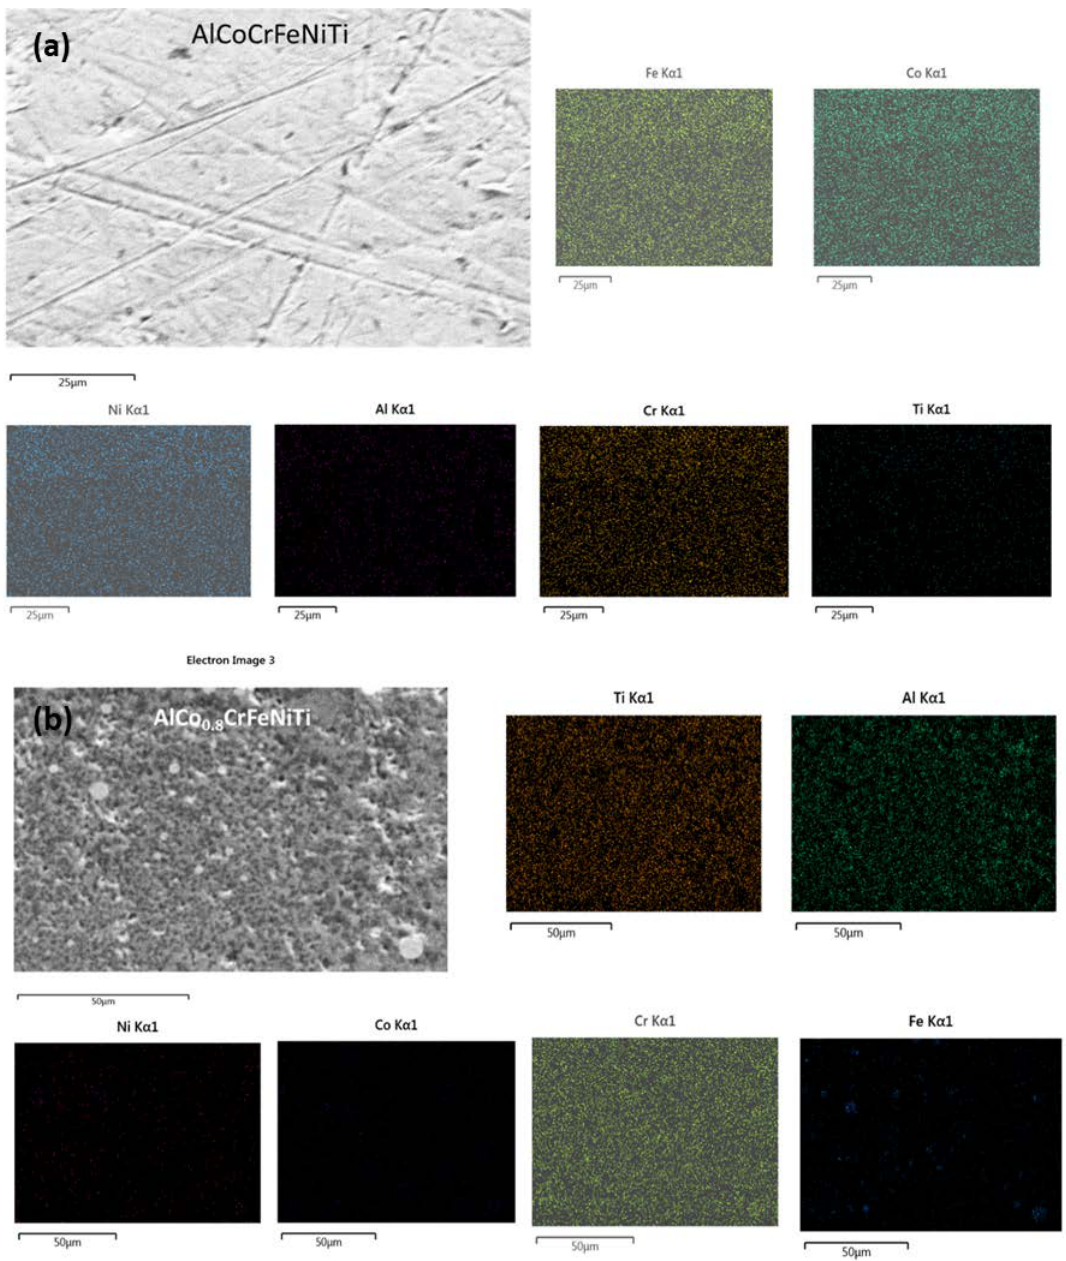
Figure A12. ( a ) SEM image and EDS elemental map of additive manufactured HEA sample (AlCoCrFeNiTi). ( b ) SEM image and EDS elemental map of additive manufactured HEA sample (AlCo 0.8 CrFeNiTi).